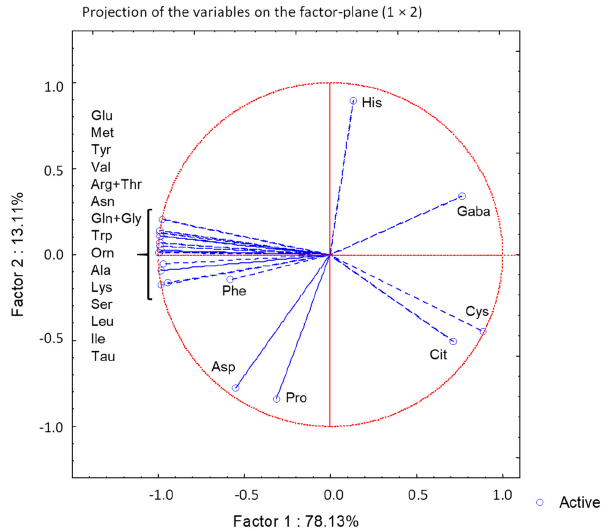
Figure 1. Principal component analysis for free amino acids in Zamorano cheese after 240 days’ ripening as a function of breed through the representation of projections.